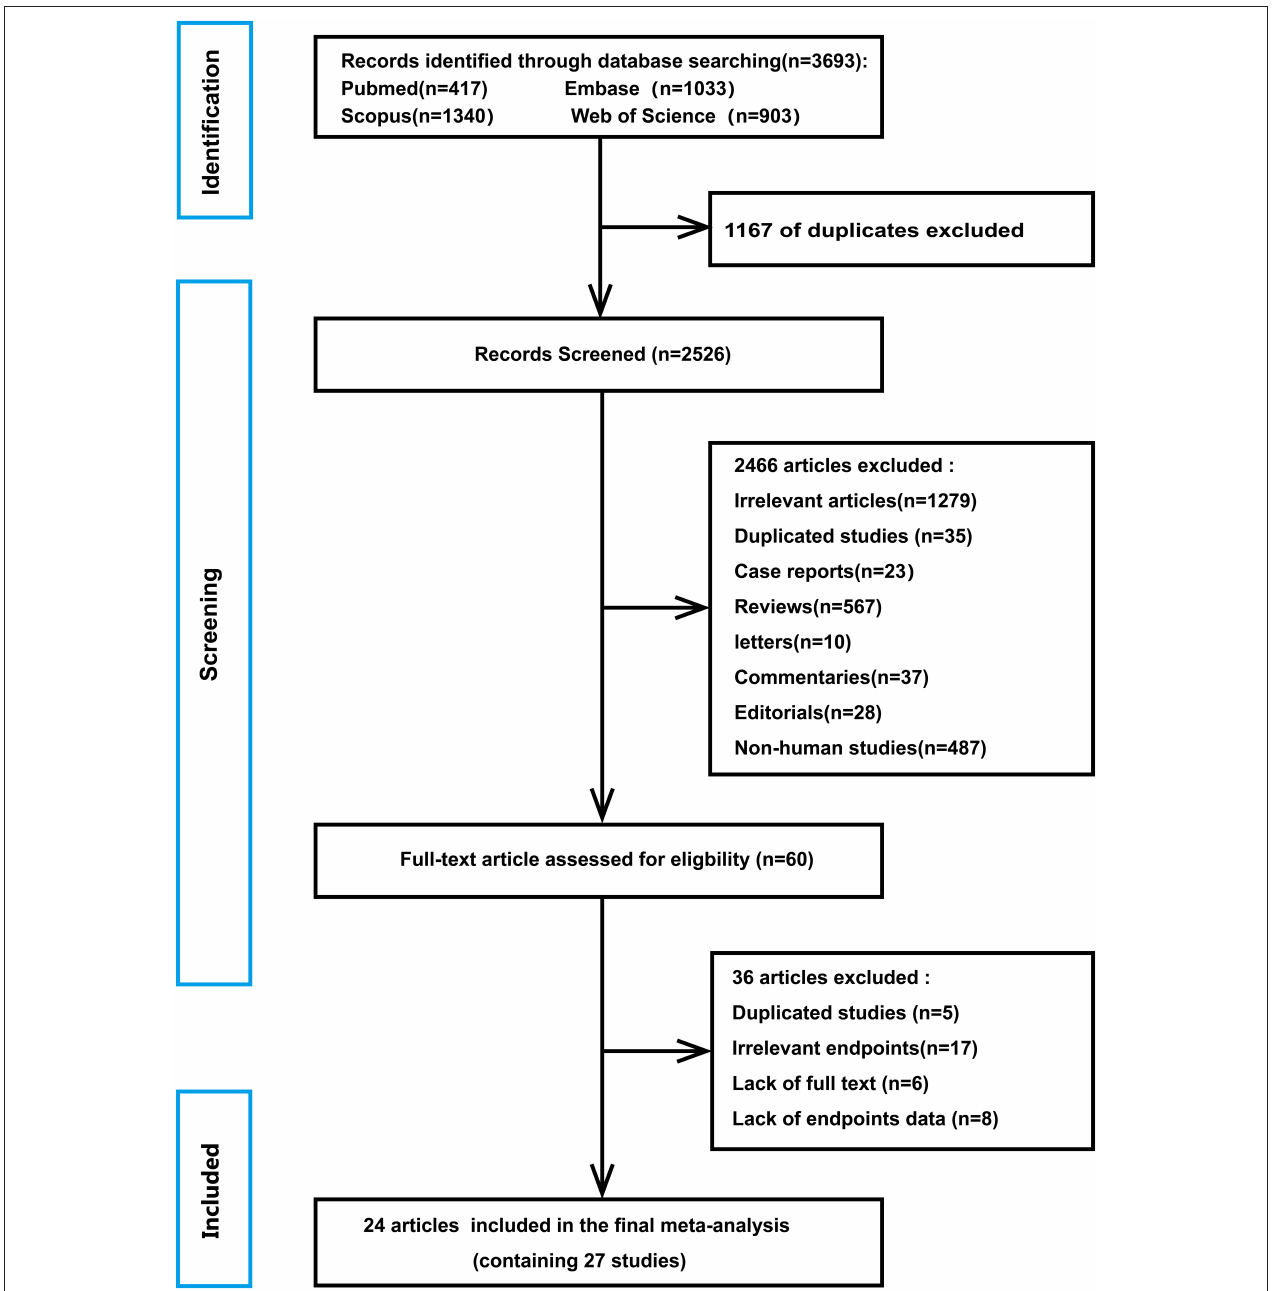
FIGURE 1 | The procedure of database search and text